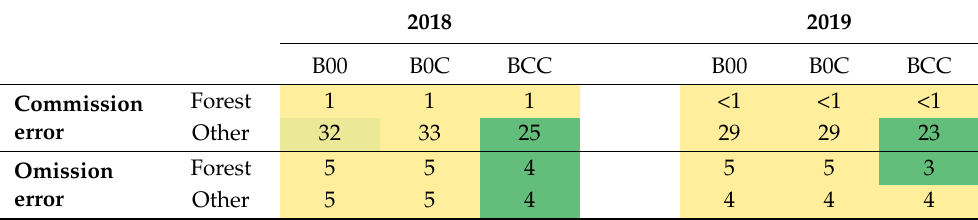
Table 7. Tropical site errors (%) based on GEDI forest presence/absence validation dataset. B00— classification using backscatter annual statistics, B0C—adding long-term coherence, and BCC—fur- ther adding short-term coherence statistics. Complete matrices in Appendix A (Table A4). Cells are shaded with a green-yellow gradient, indicating lower and higher errors.